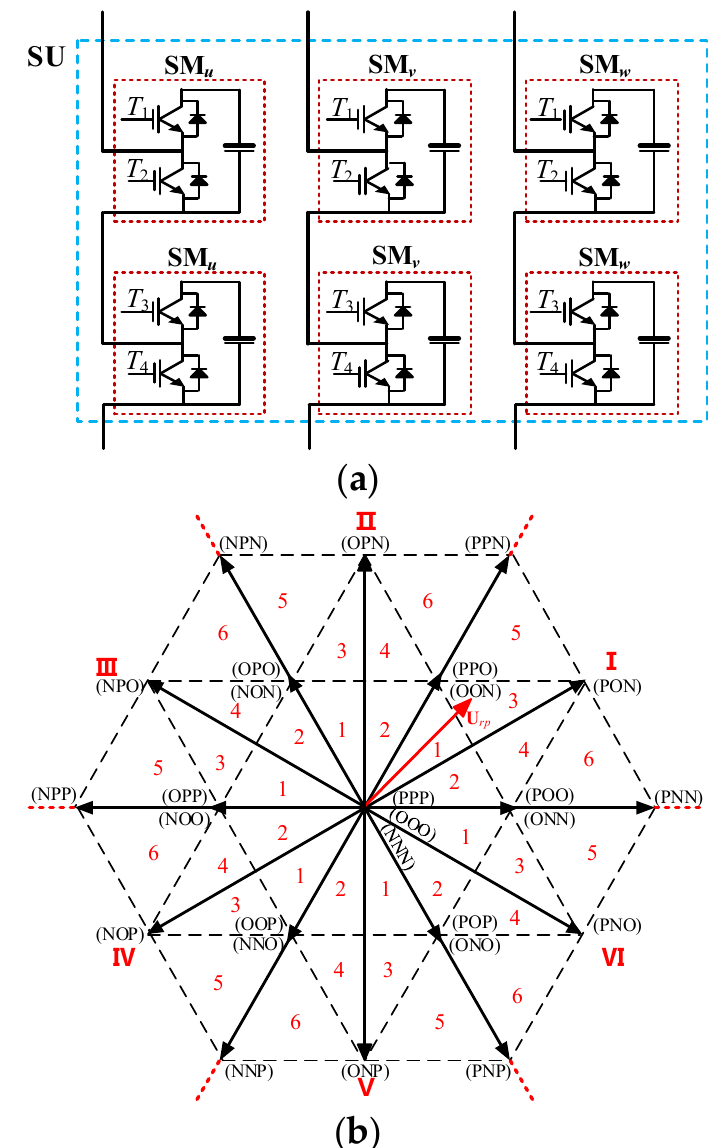
Figure 2. SMs grouping management to form three-level SUs ( a ) three-level SU and its ( b ) space vectors diagram.